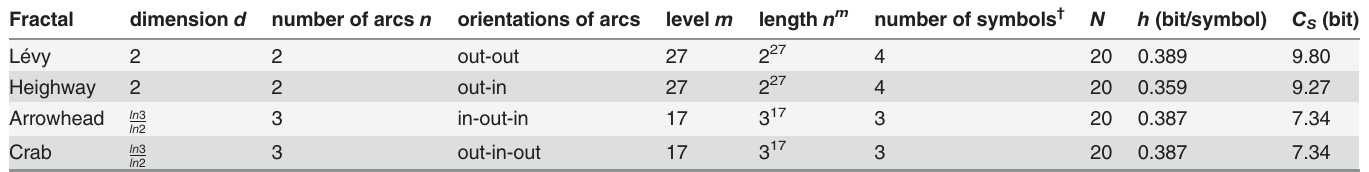
Table 4. Results of arc-fractal sequences with 2 arcs (Heighway and Lévy) and 3 arcs (arrowhead and crab).